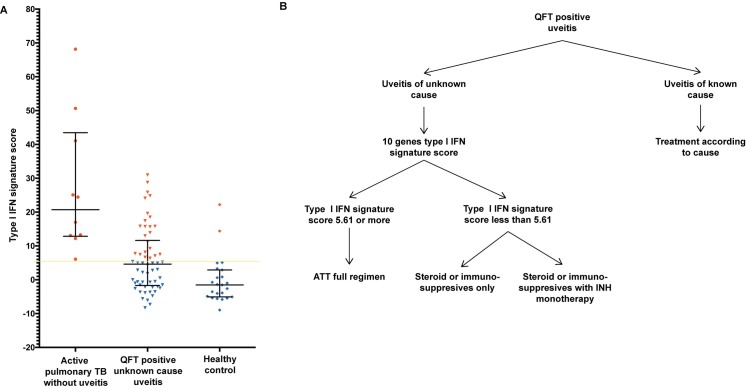
Proposed algorithm for the diagnostic work-up of QFT-positive uveitis.A. Scatter plot of type 1 IFN signature scores for QFT-positive patients with uveitis of unknown cause, patients with active pulmonary TB without uveitis and healthy controls. Each point represents one individual. Horizontal bars indicate the median value within a group. Yellow horizontal bar marks the cut off value of 5.61 for a positive versus a negative type 1 IFN gene signature score. Therefore, symbols indicated in red represent type1 IFN gene signature score positive individuals and blue symbols indicate type1 IFN gene signature score negative individuals. B. Algorithm for the management of QFT-positive uveitis patients. QFT-positive patients with uveitis of known causes should be treated appropriately for that cause. In QFT-positive patients with uveitis of unknown causes, the 10-gene type 1 IFN score can be calculated. When the score is 5.61 or more, we recommend to give the patient a full ATT regimen and the necessary anti-inflammatory treatment regimen. When the score is less than 5.61, the patient can defer ATT and can undergo anti-inflammatory treatment with or without an Isoniazid (INH) prophylaxis regimen with strict observation.